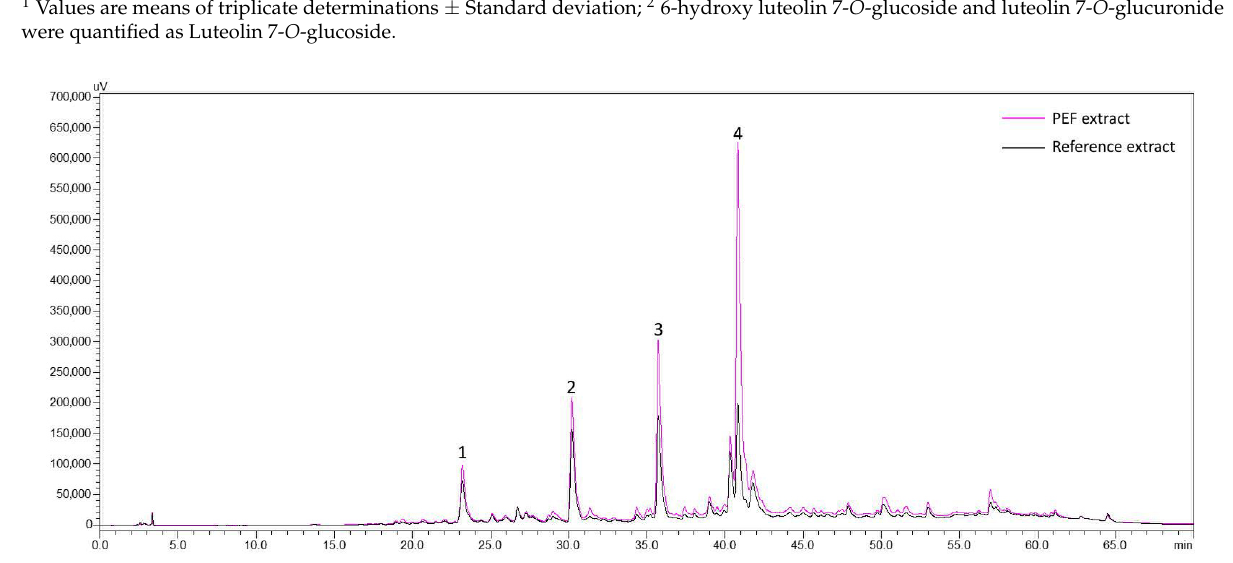
Figure 3. Overlay of chromatograms of PEF-treated and reference extracts at 320 nm with pulse duration 100 μs and extraction solvent 25% EtOH. Peak 1: Caffeic acid; Peak 2: 6-Hydroxy-luteolin-7- O -glucoside; Peak 3: Luteolin 7- O -glucuronide; Peak 4: Rosmarinic acid. Reference extract obtained without the application of PEF.